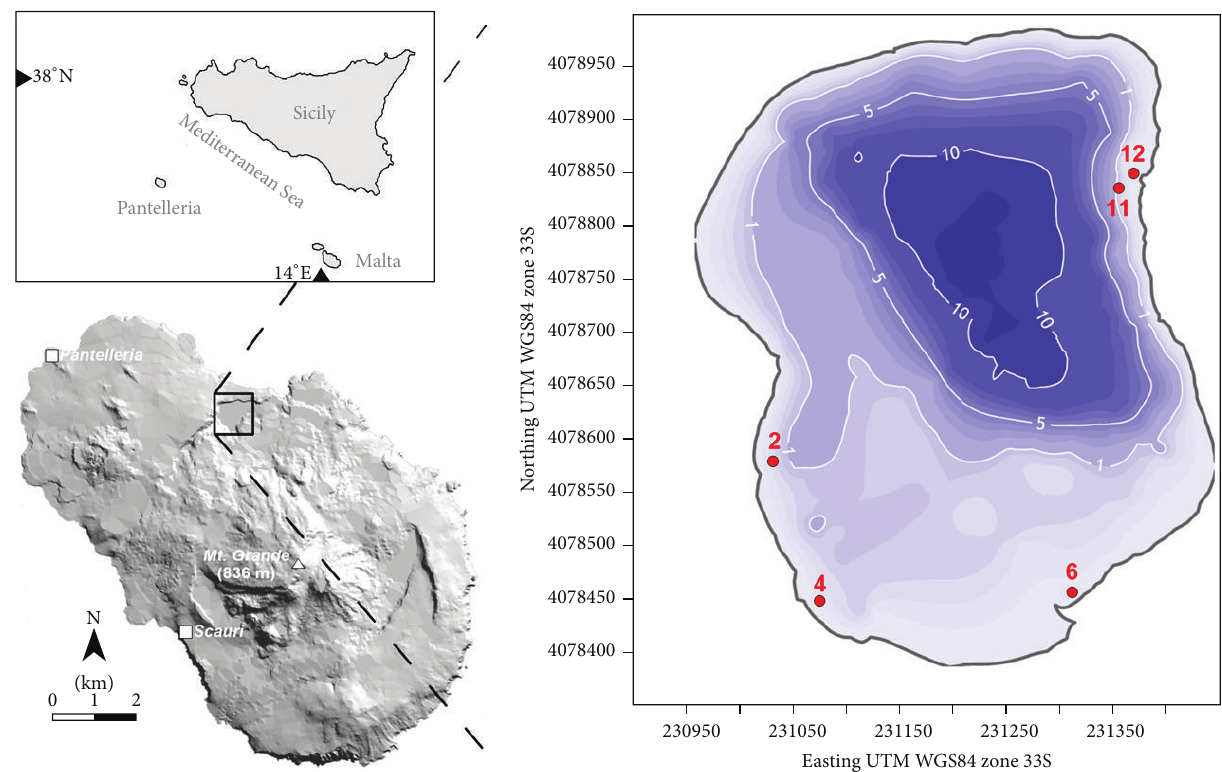
Figure 1: From the upper left counter-clockwise: location of Pantelleria island, location of lake Specchio di Venere, particularly of the lake with bathymetry (in meters below lake level), and location of sampling